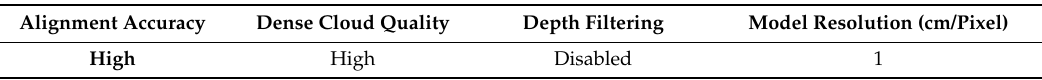
Figure 5. Orthomosaic of the 2015 field, displaying the location of Ground Control Points (GCP) and the UAV flight path used. Coordinates are displayed in WGS 1984 Coordinate System. Table 8. Agisoft processing parameters used in the 2015 study. The model resolution provided is the resolution reported by Agisoft